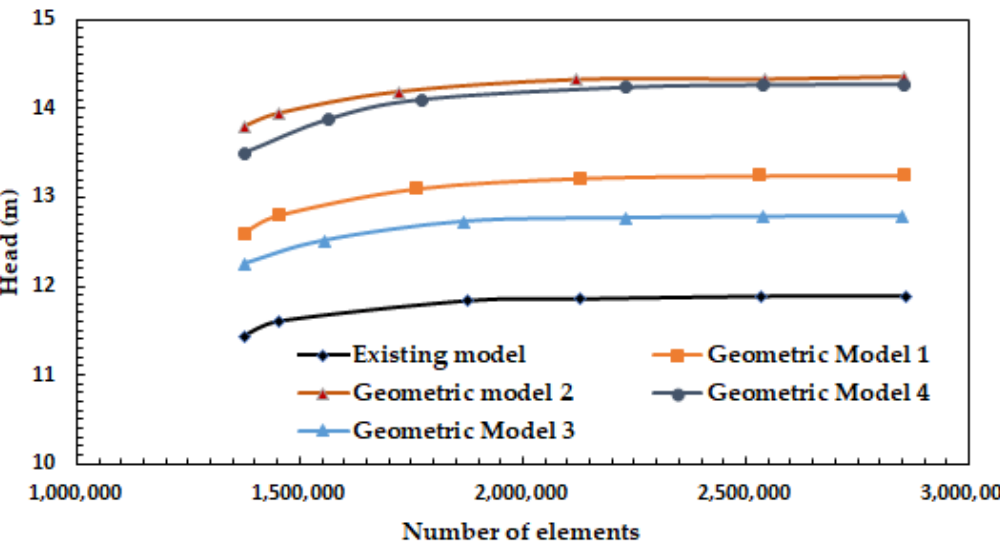
Figure 8. Mesh independence study.